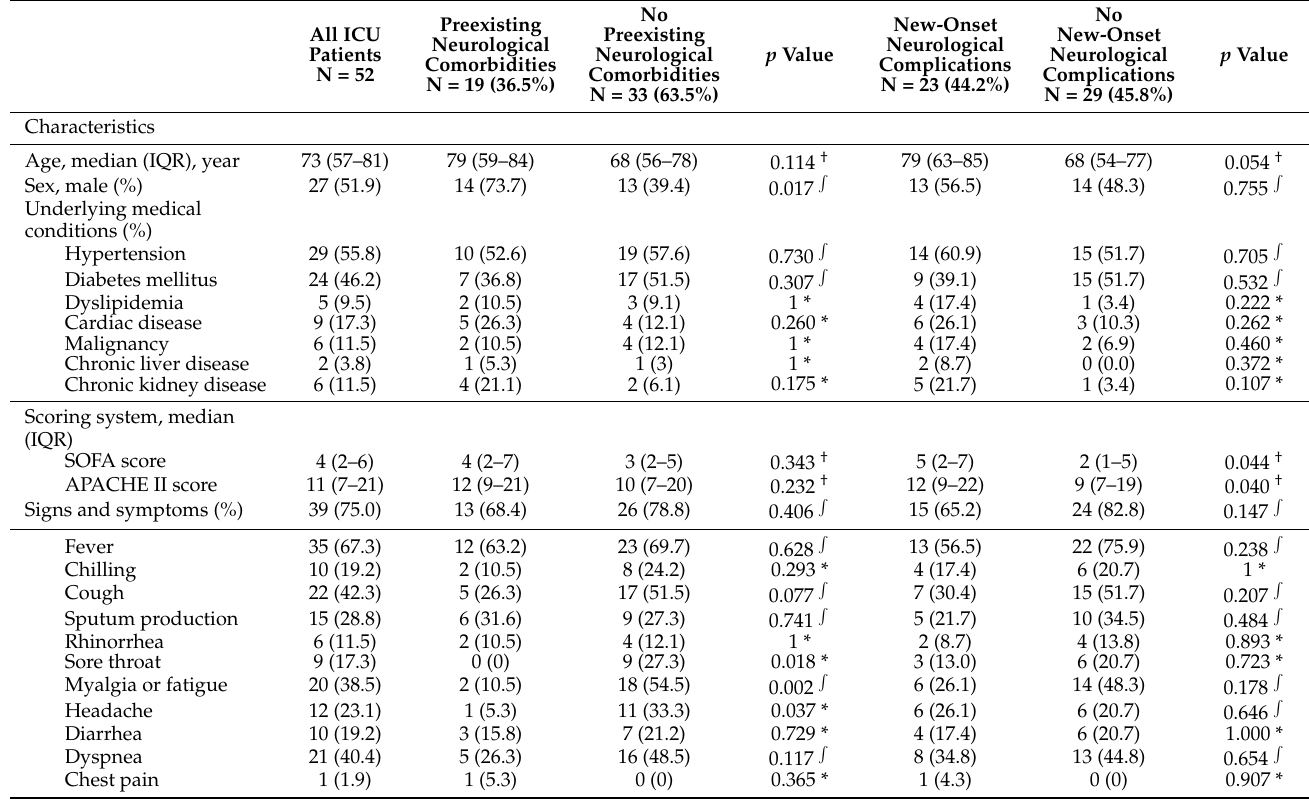
Table 1. Baseline characteristics of 52 intensive care unit patients infected with